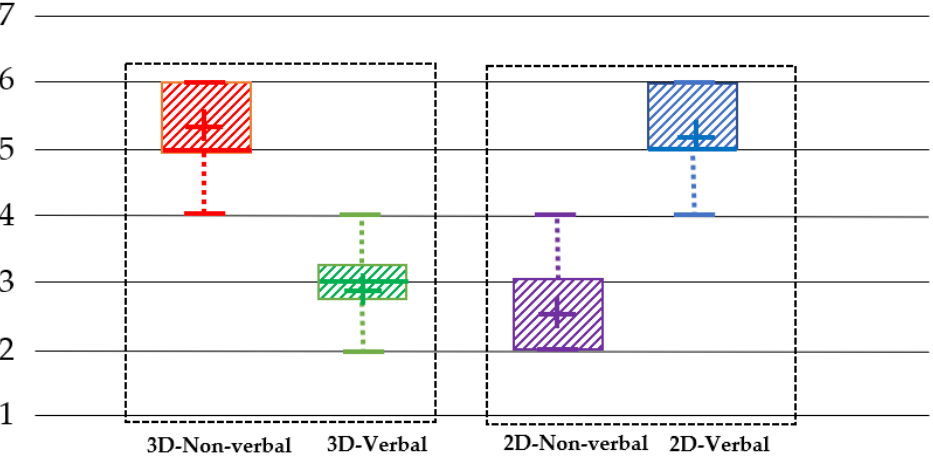
Figure 9. Level of co-presence among the four test conditions. In this figure, we compared non-verbal and verbal using a pairwise comparison. A plus sign denotes the average.